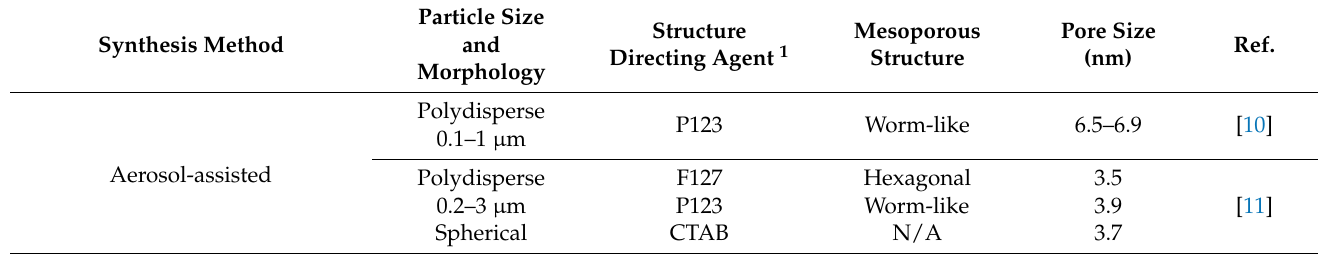
Table 1. Synthesis methods and characteristics of mesoporous bioactive